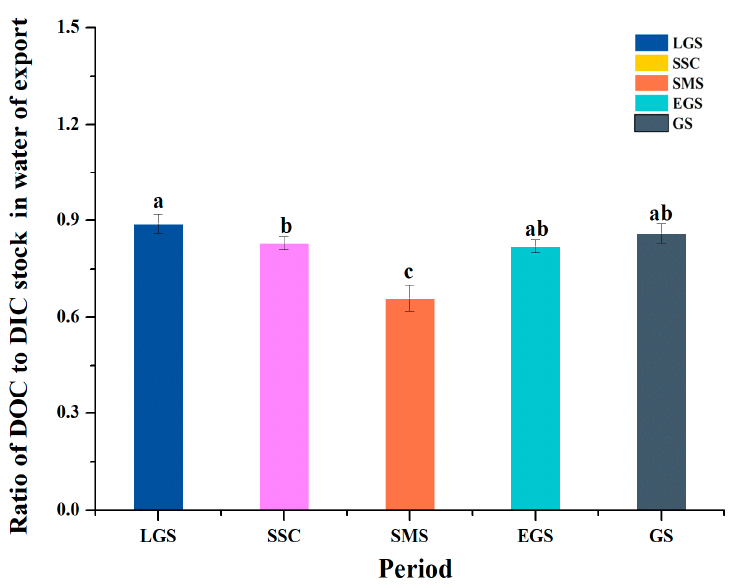
Figure 5. The ratios of dissolved organic carbon (DOC) to dissolved inorganic carbon (DIC) stocks in the export water of the subalpine forest streams in the upper reaches of the Yangtze River from 11 July 2015, to 2 August 2016. LGS, SSC, SMS, EGS, and GS indicate the sampling periods, i.e., the late growing season (LGS: September to October), seasonal snow cover (SSC: November to April of the following year), snowmelt season (SMS: April to May), early growing season (EGS: May to June), and growing season (GS: July to August), respectively. The values of the vertical coordinates are the averaged values for 15 streams in this period, and the error bars are the standard deviations of 15 streams during every period. Different lowercase letters indicate significant differences among different periods ( p < 0.05), while the same letter indicates no significant difference among each.